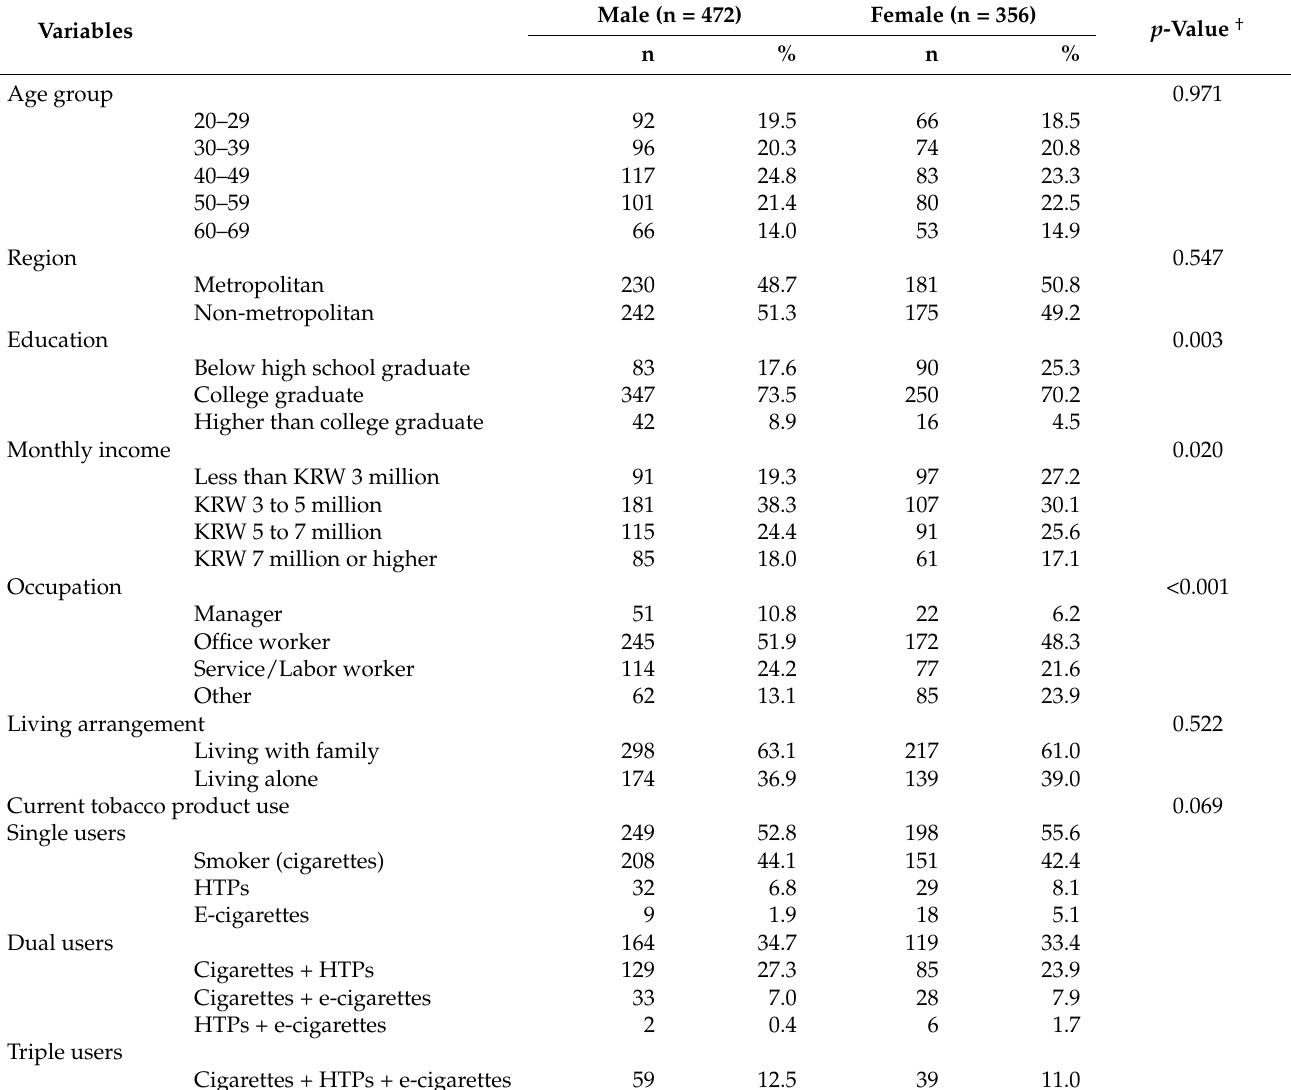
Table 1. Characteristics of the participants (n =